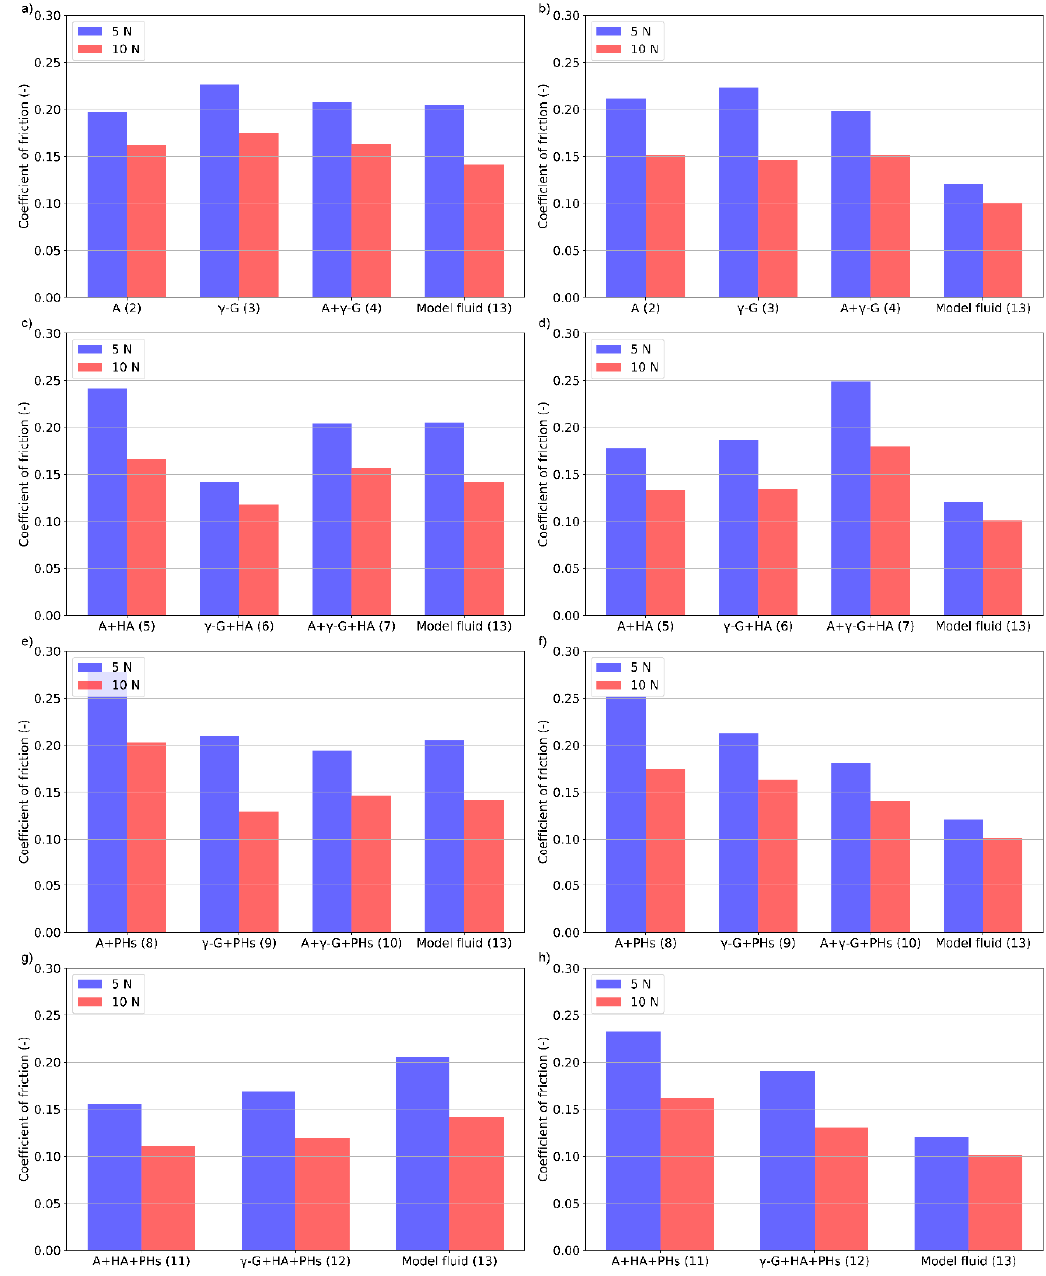
Figure 6. The effect of load on the friction coefficient for various protein- ( a , b ), HA- ( c , d ), PHs- ( e , f ), and HA + PHs- ( g , h ) based lubricants; PC ( left ) and OC ( right and HA + PHs- ( g , h ) based lubricants; PC (left) and OC (right).